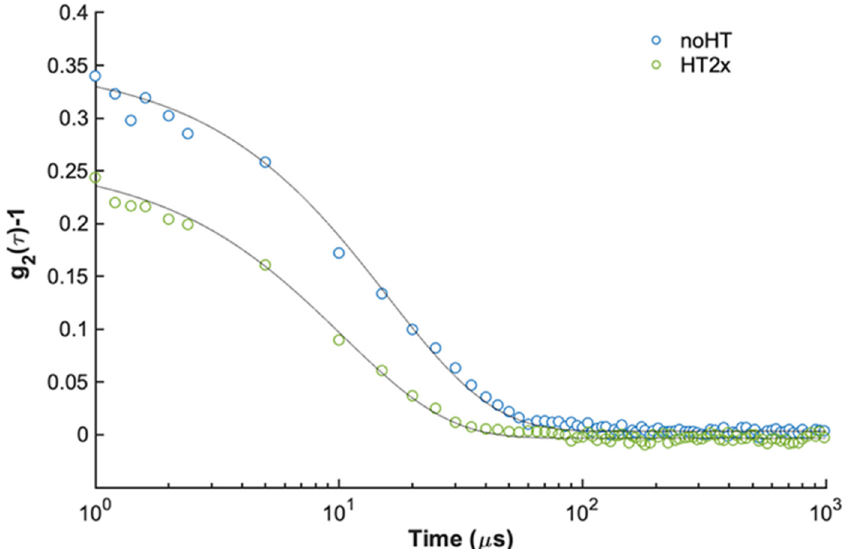
Figure 6. Effect of HT on insulin oligomerization state monitored by dynamic light scattering (DLS). Second order autocorrelation functions g 2 ( τ ) measured for 2 mg/mL, pH 7.0 insulin incubated in the absence (blue) and in the presence (green) of HT in a 2× molar ratio. Continuous lines are the best fit to single exponential functions as described in Equation (1).